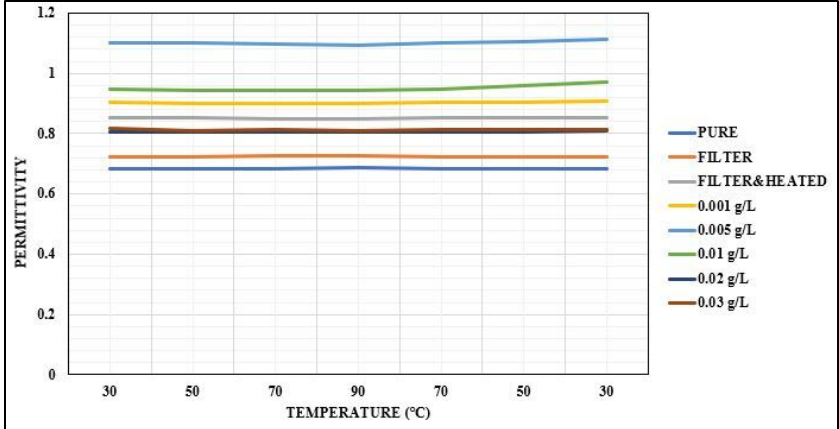
Figure 9. Permittivity value of different types of samples.